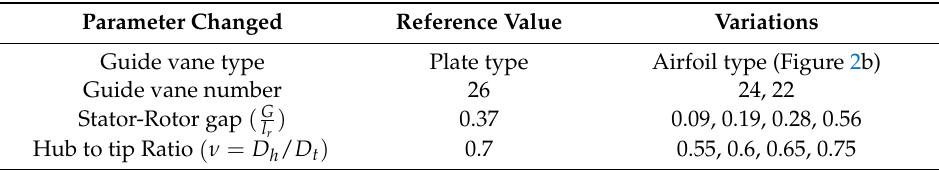
Table 1. Variations of the parameters with respect to Figure